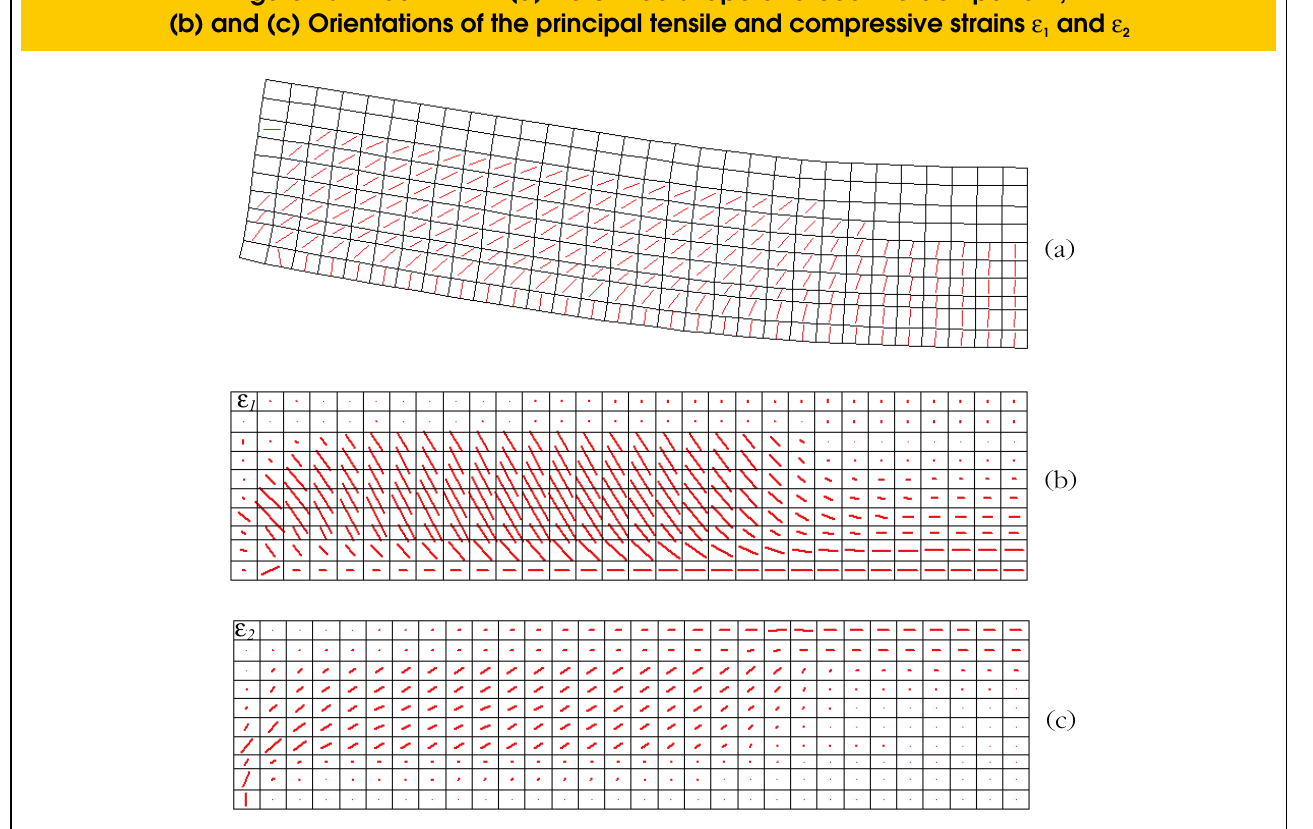
Figure 10 – Beam ET4 – (a) Deformed shape and beam crack pattern, (b) and (c) Orientations of the principal tensile and compressive strains